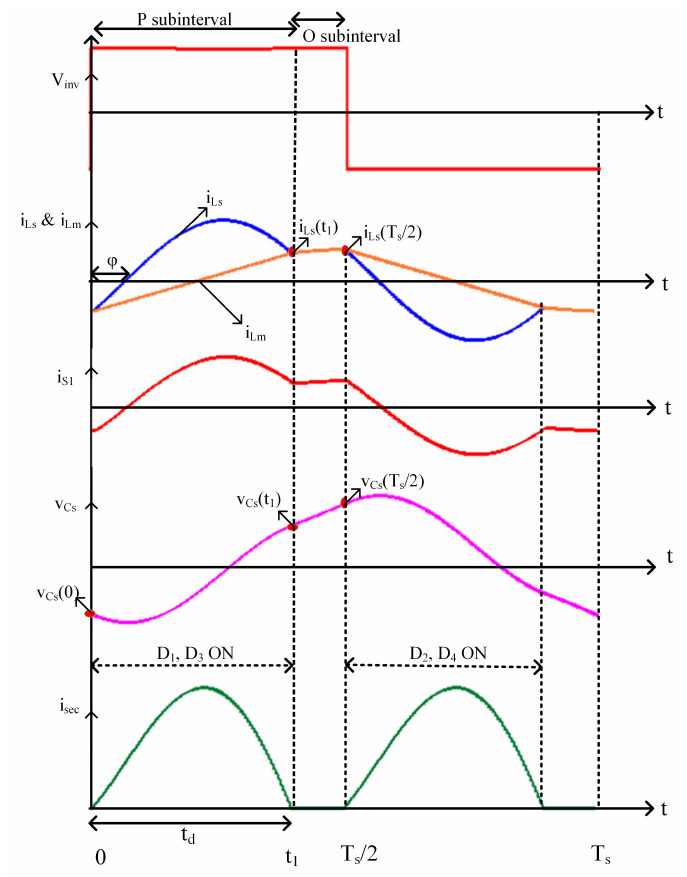
Figure 2. LLC converter steady state waveforms in PO